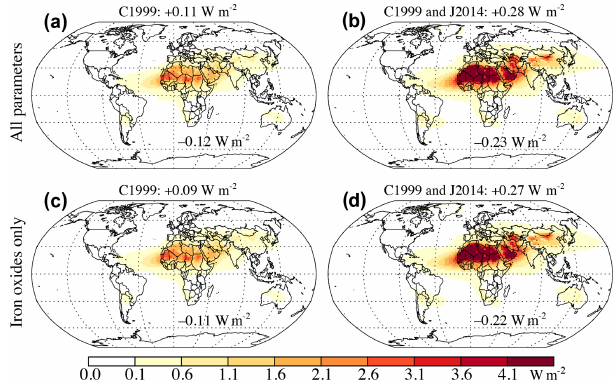
Figure 11. High-branch shortwave DRE uncertainty estimated con- sidering all parameters (a, b) and iron oxides only (c, d) in CAM5 with the soil mineral distribution coming solely from C1999 (a, c) and both C1999 and J2014 (b, d) . Numbers show the high (in the title) and low branches (inlet) of the global mean uncertainty es- timated based on the global average shortwave DRE in individual cases (see Sect.